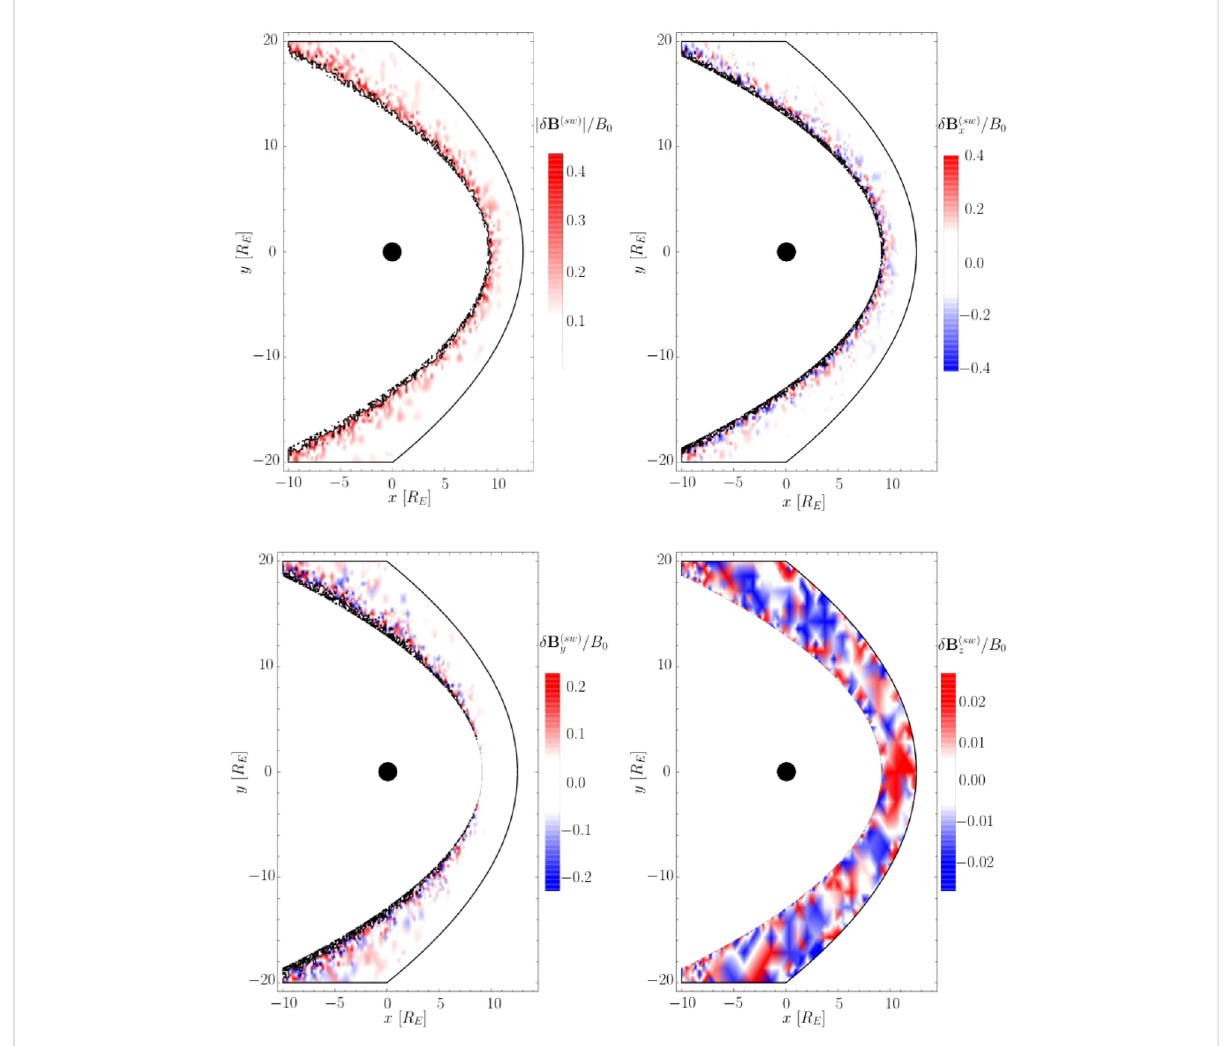
FIGURE 3 Relative error of the reconstructed amplitude and the components of the upstream fi eld resulting from disturbed